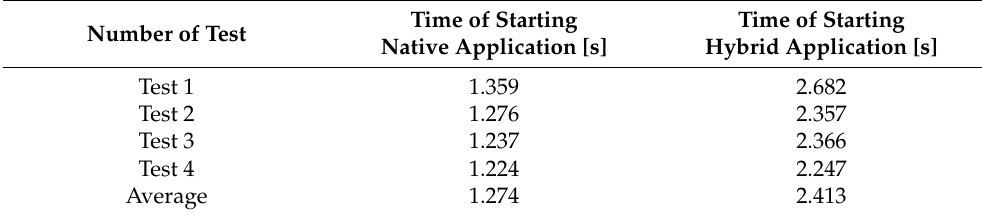
Table 2. Time taken to start the applications.